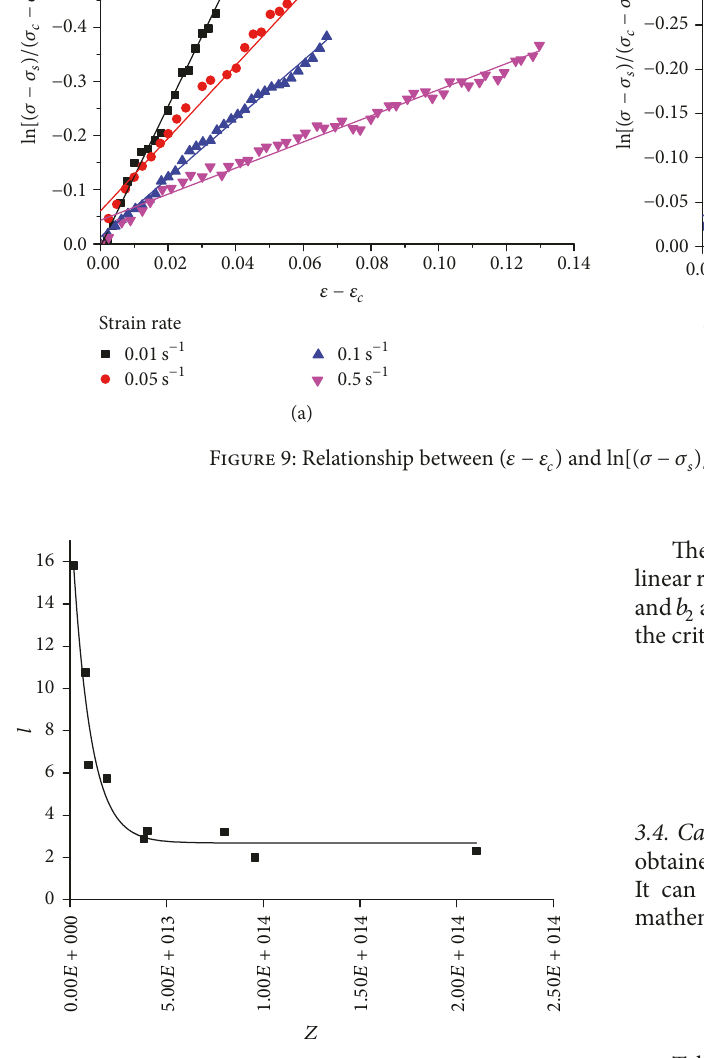
Figure 10: Relationship between 𝑙 and 𝑍